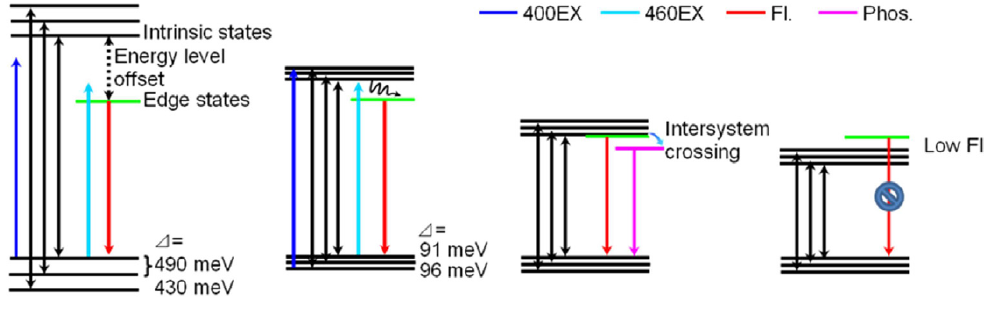
Figure 7. The electronic level structures of CDs of different sizes, as proposed in [166]. The intrinsic state depends on size, hence the energy level offset with the edge state, which ultimately decides the optical properties. Certain alignments between states also open a possibility for intersystem crossing and subsequent long-lived triplet emission. The latter, however, is very difficult to observe experimentally in most CDs. Reproduced with permission from [166]. Copyright Elsevier,